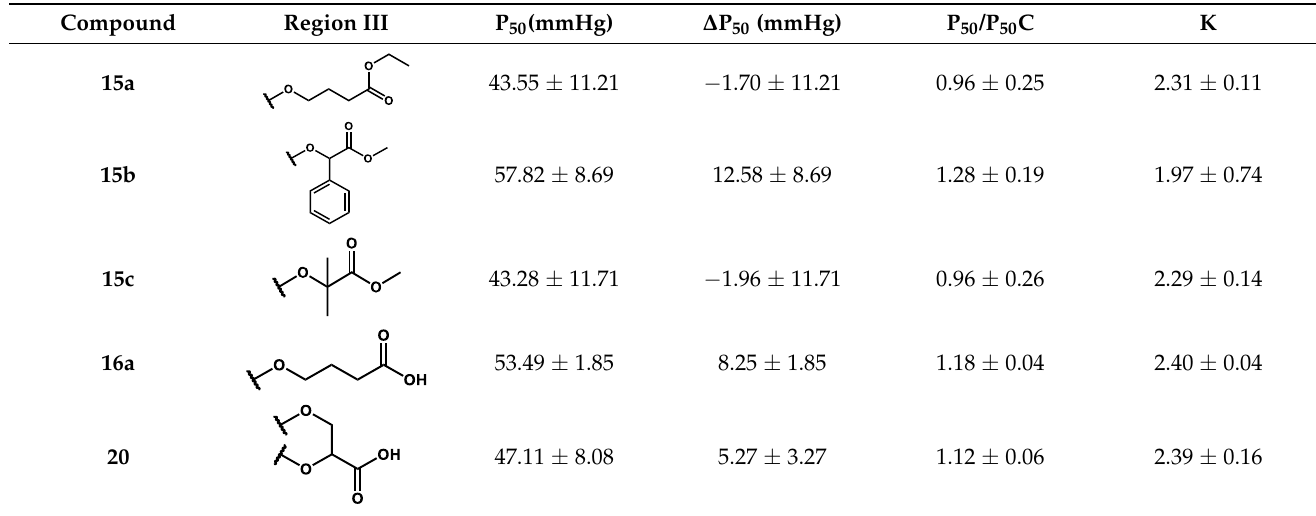
curve when the red blood cells are 50% saturated. Data are displayed as mean ± SD.